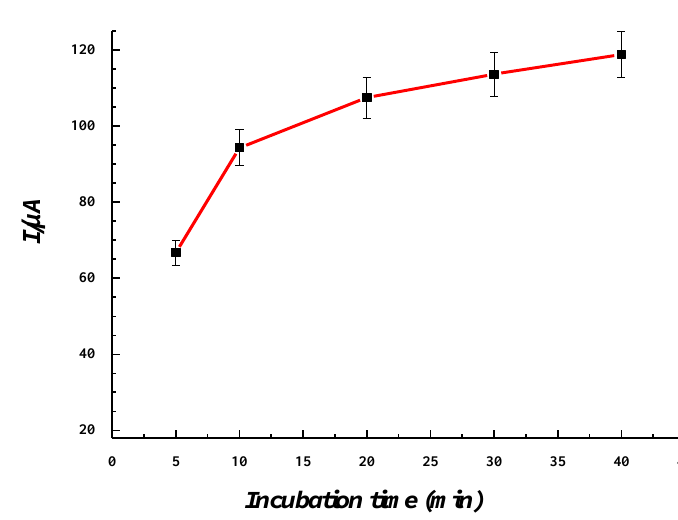
Figure 9. Hg-IIP response after di ff erent incubation times in 10 − 4 M mercury solution / H 2 O / KCl 0.1 M.